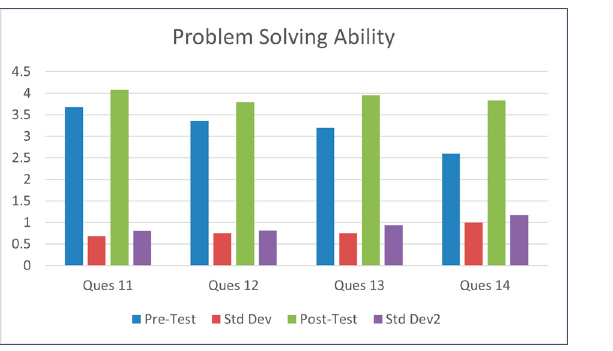
Figure 9. Students’ problem-solving ability in the previous test and the post-test.